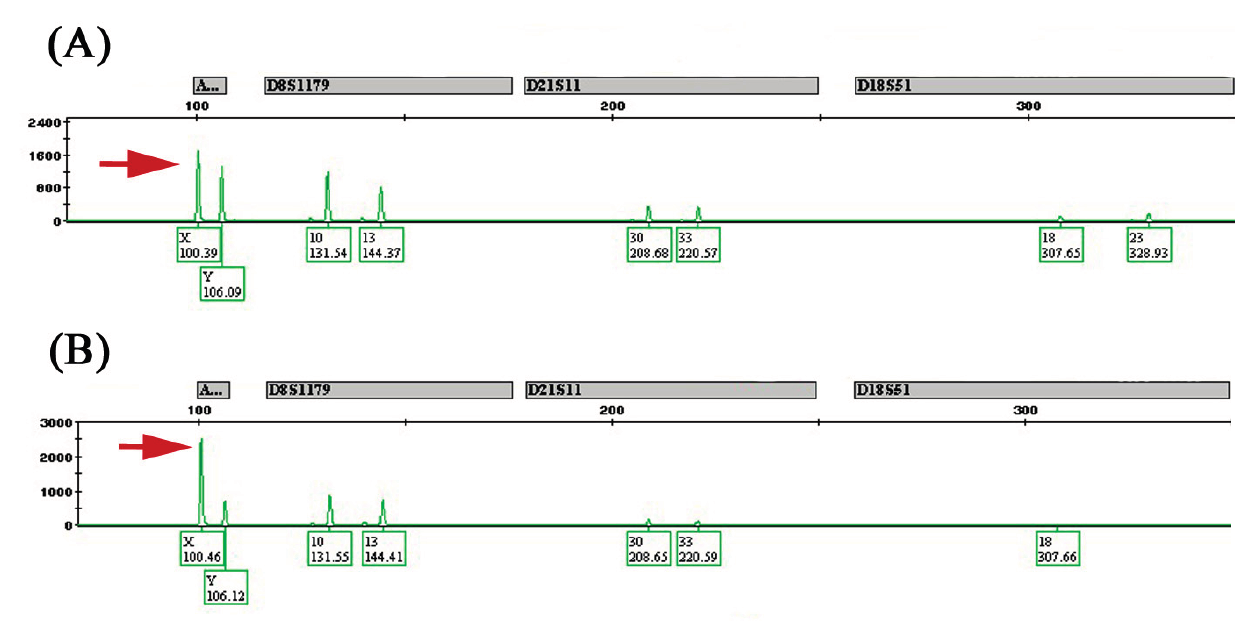
Figure 4. Allelotyping. ( A ) Normal DNA from a male patient showing X and Y peaks of equal height (arrow); ( B ) Tumor DNA from same patient showing X peak more than twice the height of the Y peak (arrow) indicating X